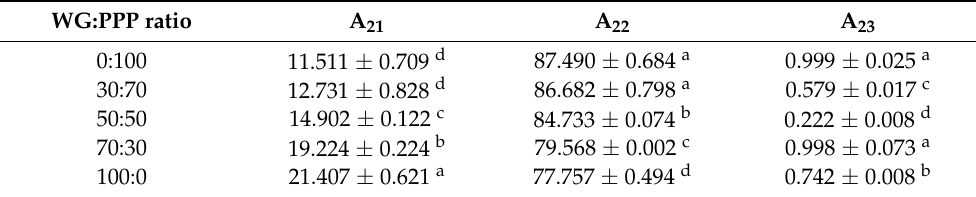
Table 5. Proportions of peak areas (A 2 ) of extrudates with different mixing ratios.